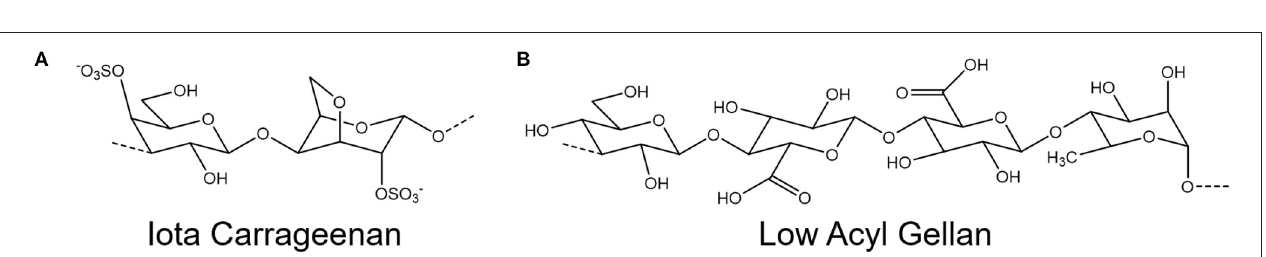
FIGURE 2 | Chemical structure of the repeating units of (A) iota carrageenan and (B) low acyl gellan.